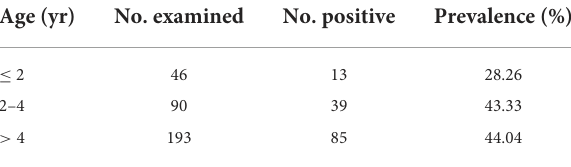
TABLE 4 Seroprevalence of N. caninum infection in different age groups of dairy cattle using ELISA in Ningxia of China. Age